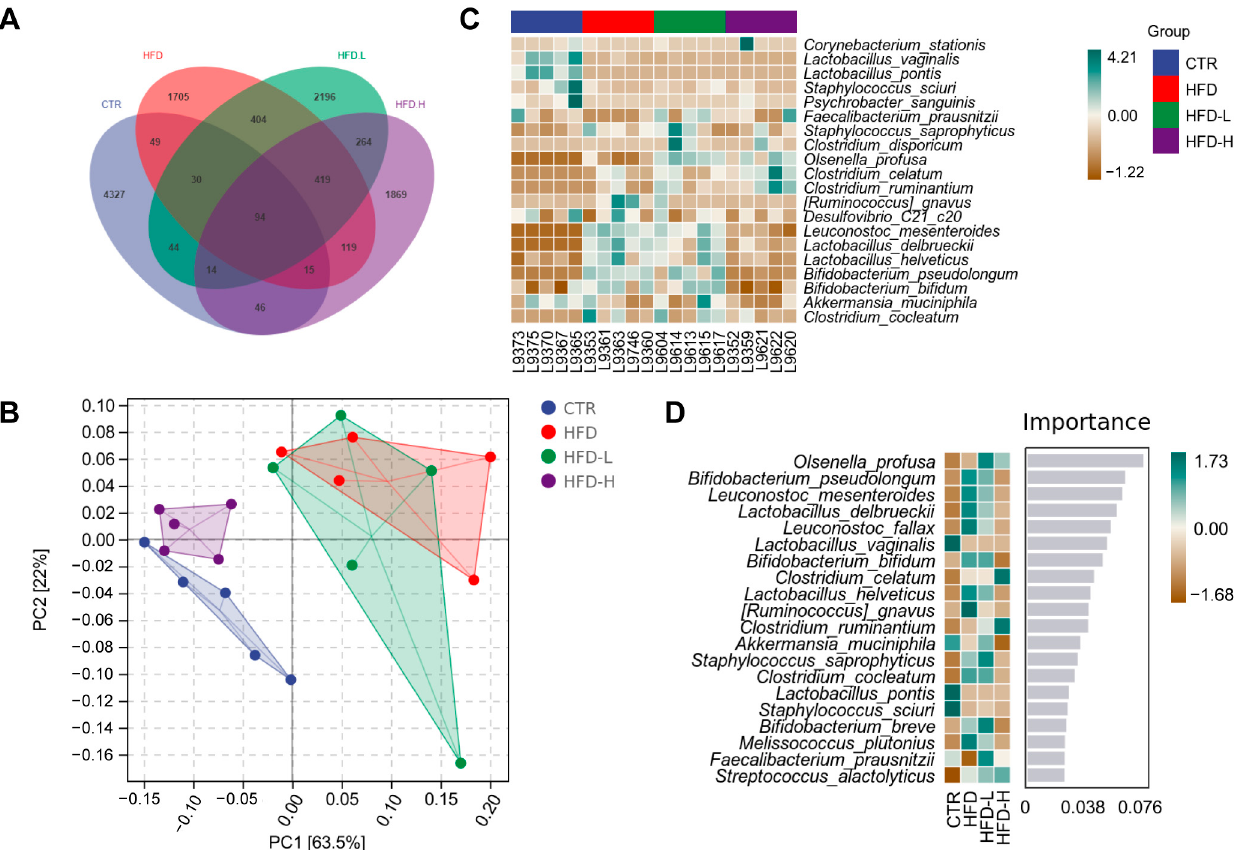
Figure 7. Comparative analysis of the gut microbiota in response to SMRR polysaccharide supplement. ( A ) Venn diagram showing the unique and shared ASVs from different groups. ( B ) The diagram of Principal Component Analysis (PCA) displaying close clustering between CTR and HFD+H group, while HFD is close to HFD+L. ( C ) Heatmap depicting the relative abundances of the 20 bacterial species significantly enriched in different samples of different groups. ( D ) Heatmap of Random Forest Classifier showing the relative abundances of the top 20 bacterial species of most importance in different groups.